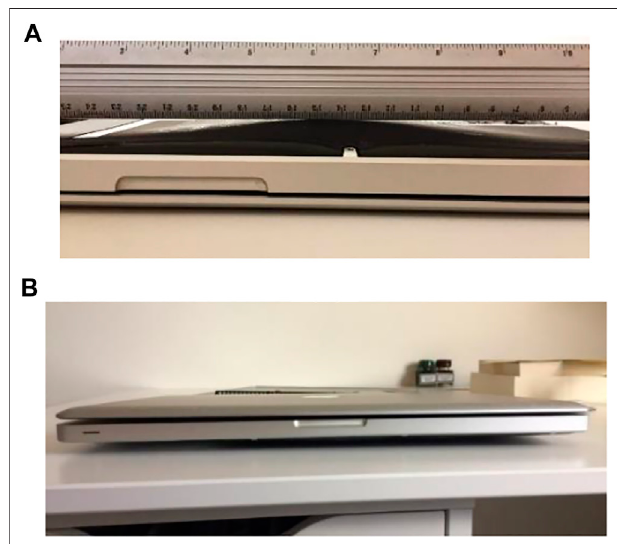
FIGURE1| MacBookPro2011withswollenbatteries(Apple,2017). (A) Bottomviewofmechanical enclosure bulging due toswelling. (B) Front facing view of mechanical enclosure.